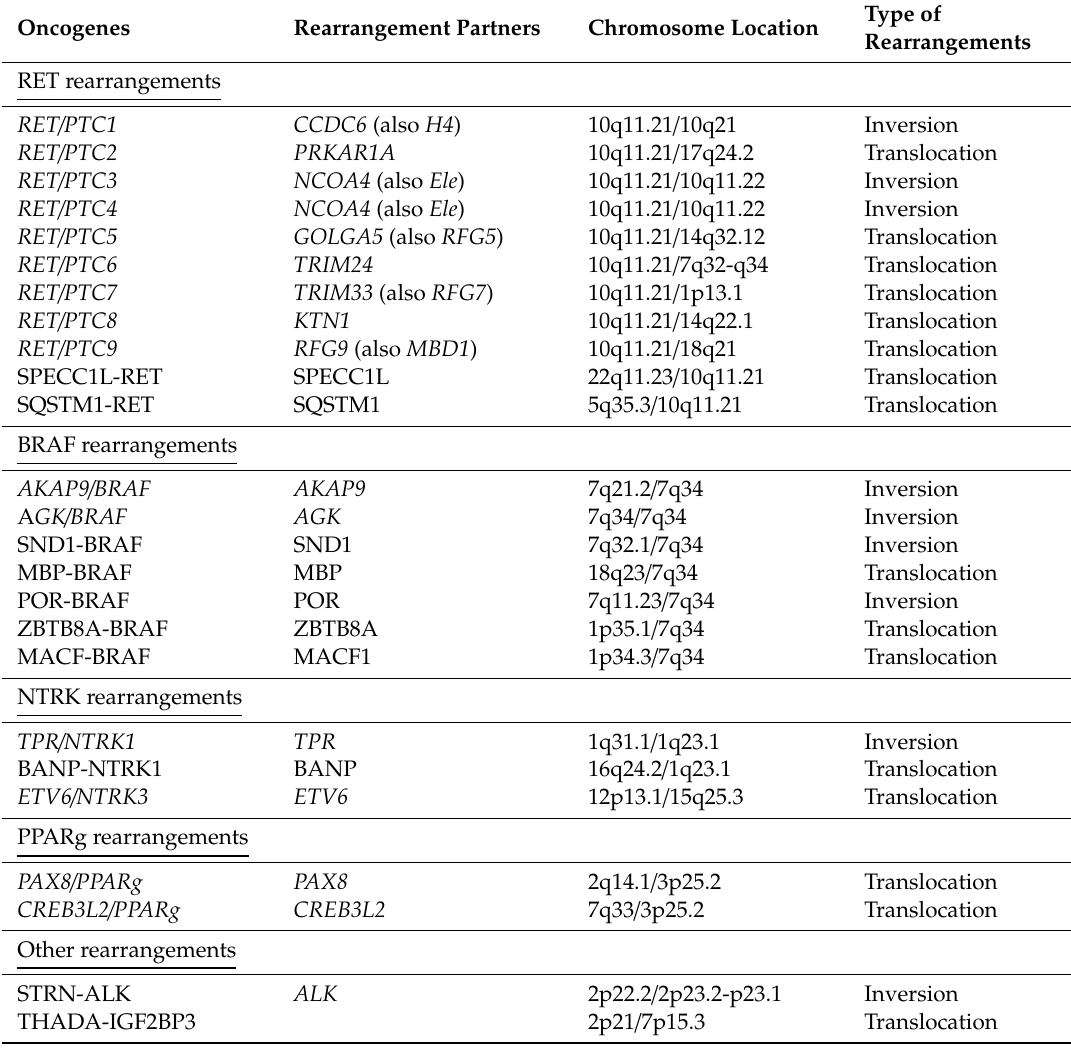
Table 1. Oncogenic rearrangements in childhood thyroid cancers related to the Chernobyl